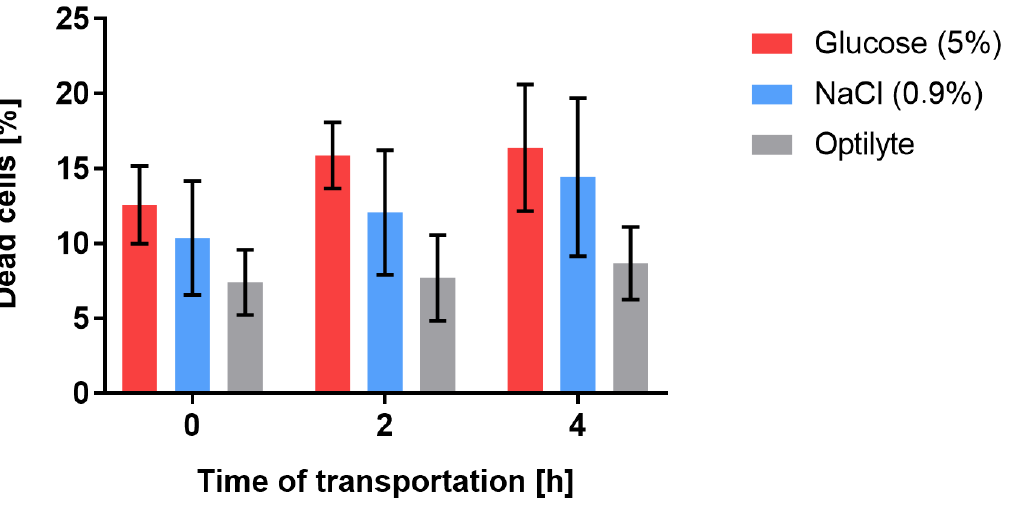
Figure 3. Cell viability in different transport media in time ( n = 3). The results are presented as mean ± SD.